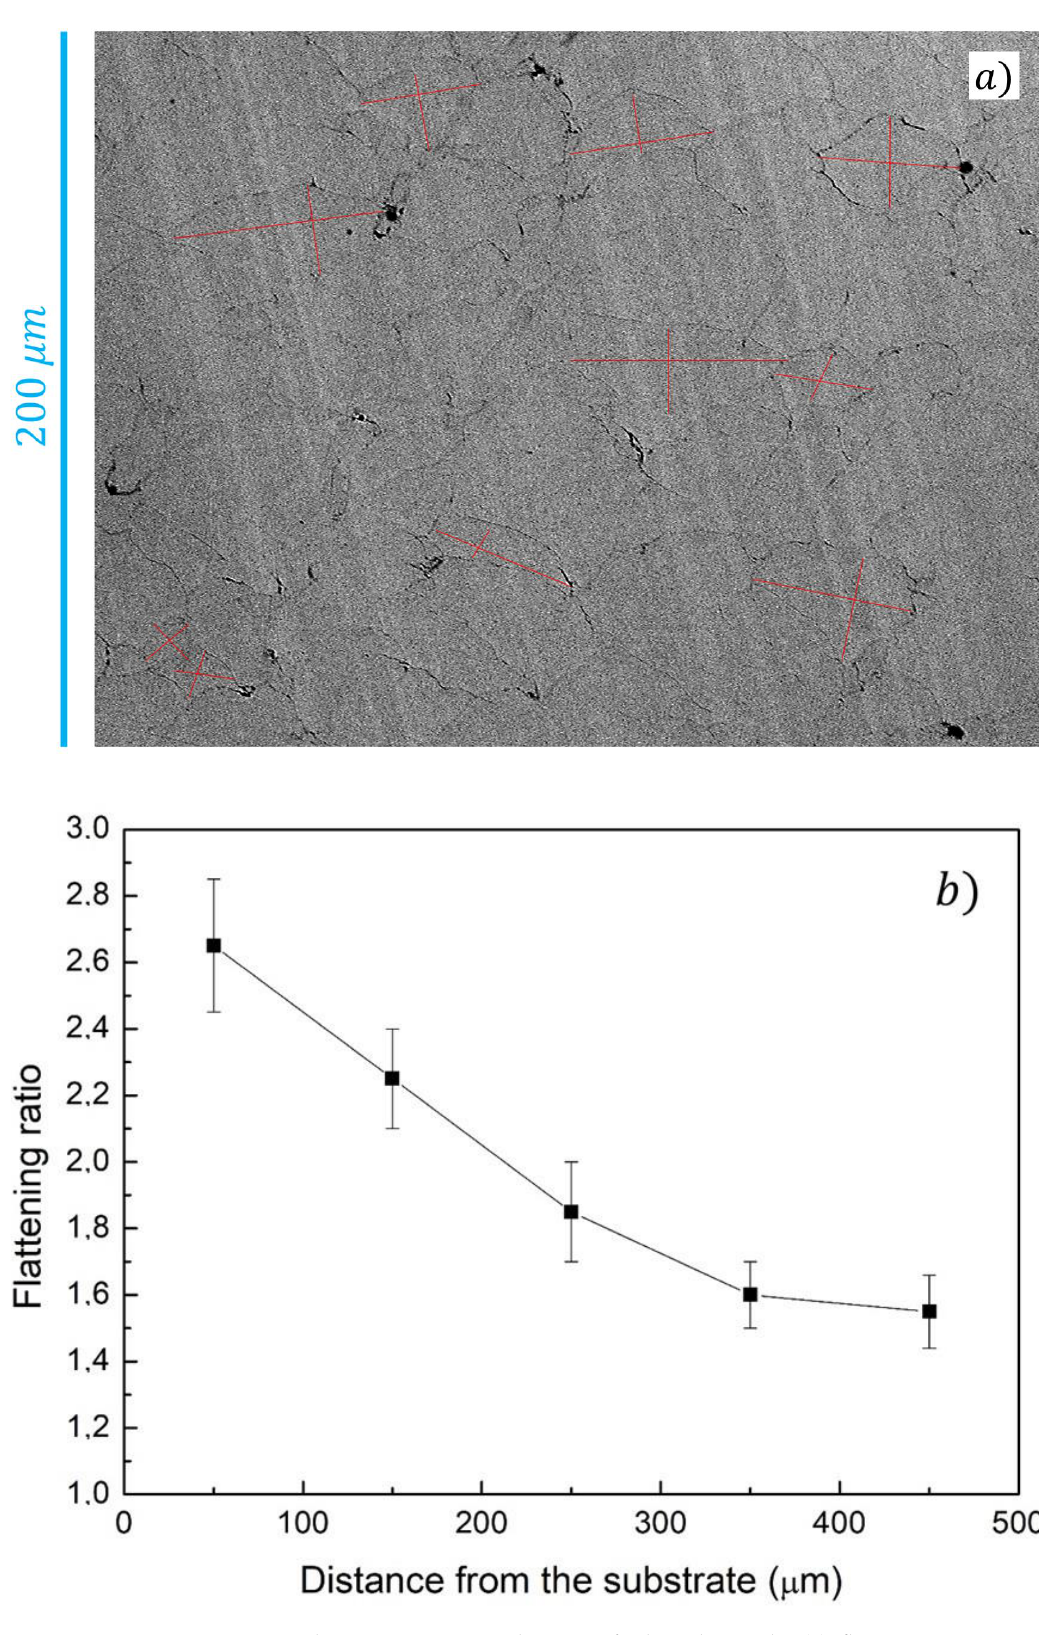
Figure 4. Flattening ratio visualization of selected particles ( a ); flattening ratio as a function of the distance from the substrate ( b